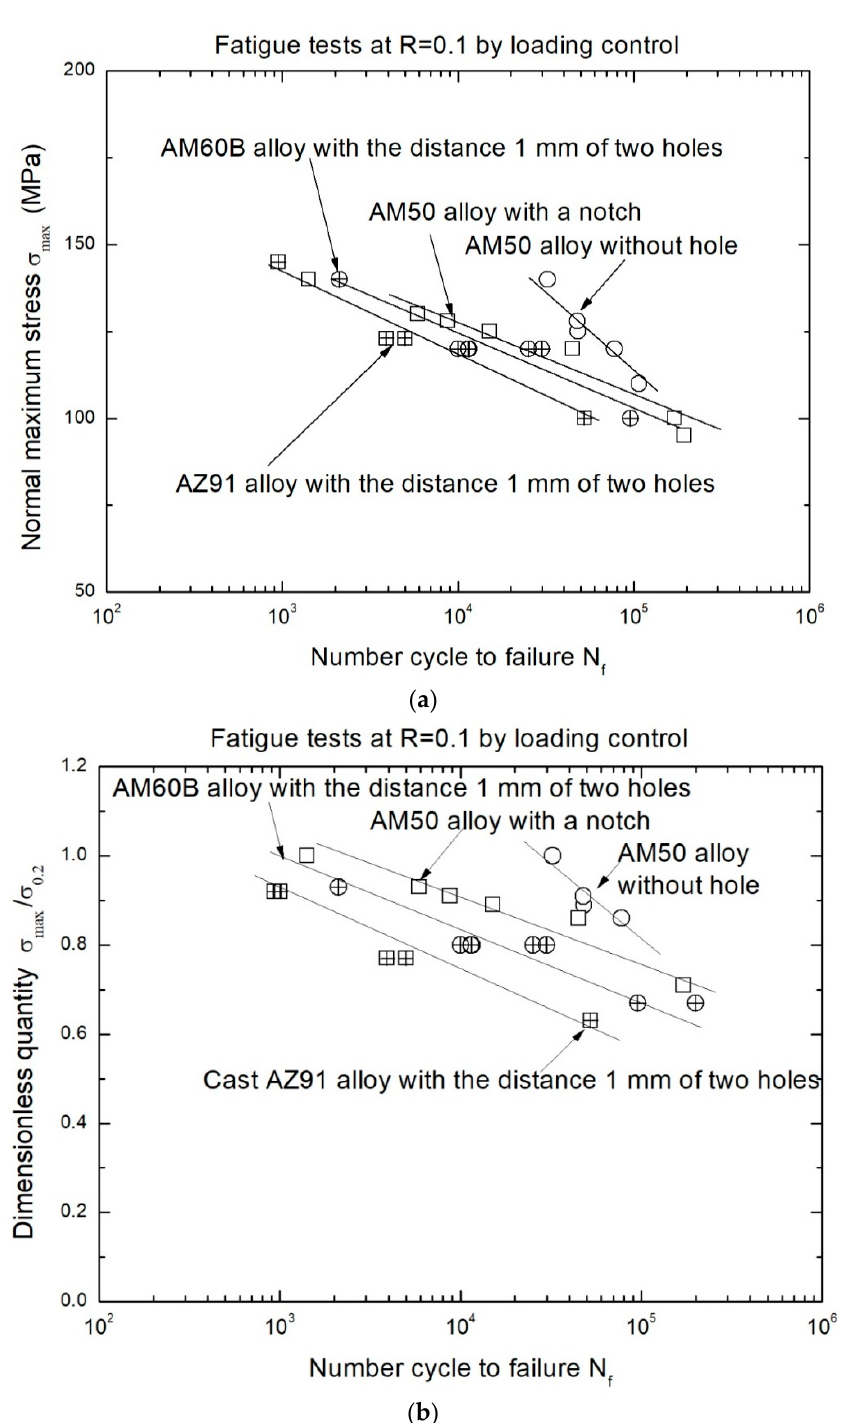
Figure 2. S-N curves of cast Mg-Al alloys under different testing conditions. ( a ) S-N curves of cast Mg-Al alloys with the σ max parameter; ( b ) S-N curves of cast Mg-Al alloys with the λ ( σ max / σ 0.2 )